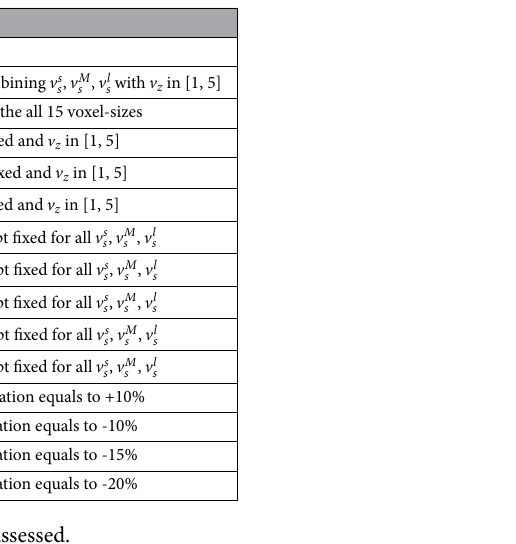
Table 3. Descriptions of the 29 perturbations